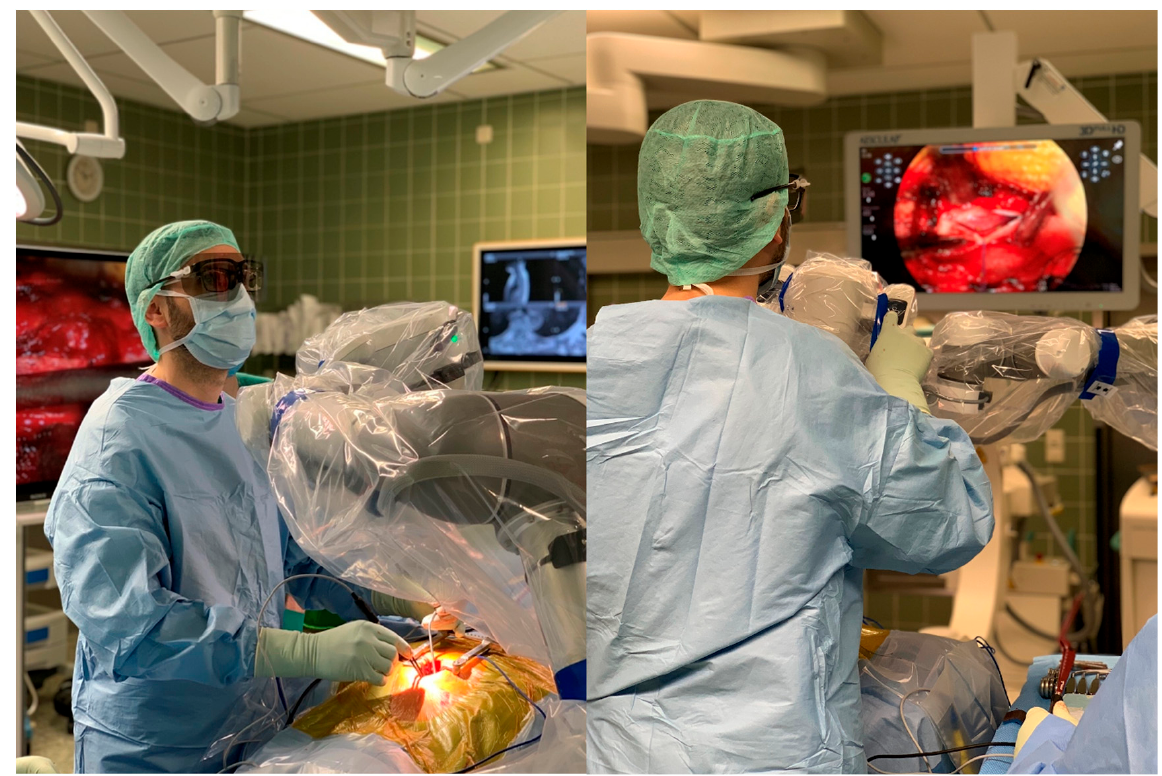
Figure 1. The surgeon during an operative resection of a meningioma TS 4/5 using the Three-Dimensional Robotic Digital Microscope.